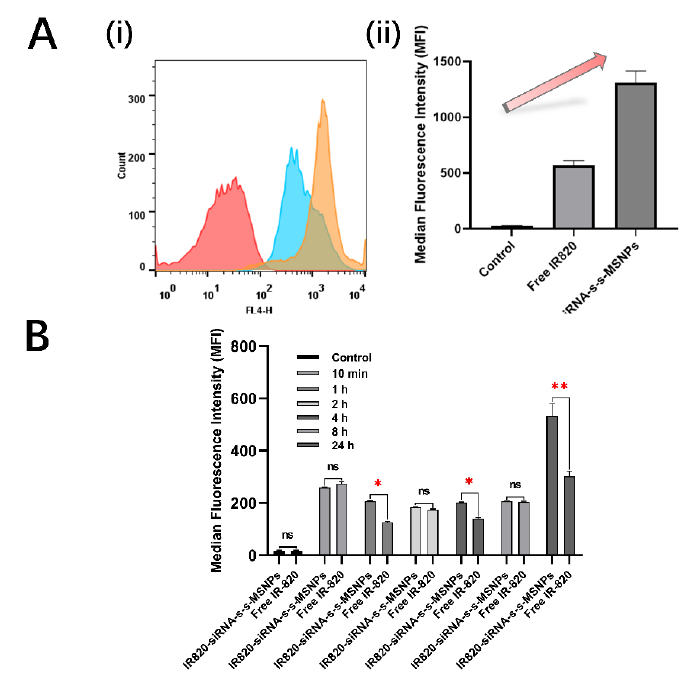
Figure 5. Evaluation of IR820 NIR signal penetration rate in RH30 sarcoma spheroids measured by flow cytometry. ( A ) (i) Representative flow cytometry histogram result for single cells from breaking RH30 sarcoma spheroids. Cells were incubated with either PBS (red), free IR820 NIR dye